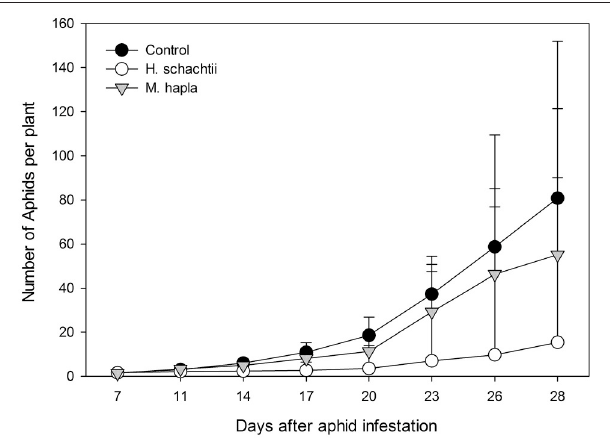
FIGURE 1 | Average numbers ( ± SEM) of Brevicoryne brassicae aphids found per plant from 7 to 28 days after five 2-day old nymphs were released on each plant (no-choice experiment; n = 10 per treatment group). Plants were either infested with Heterodera schachtii (white circles) or Meloidogyne hapla (gray triangles) or mock inoculated (black squares) 7 days before aphids were released.